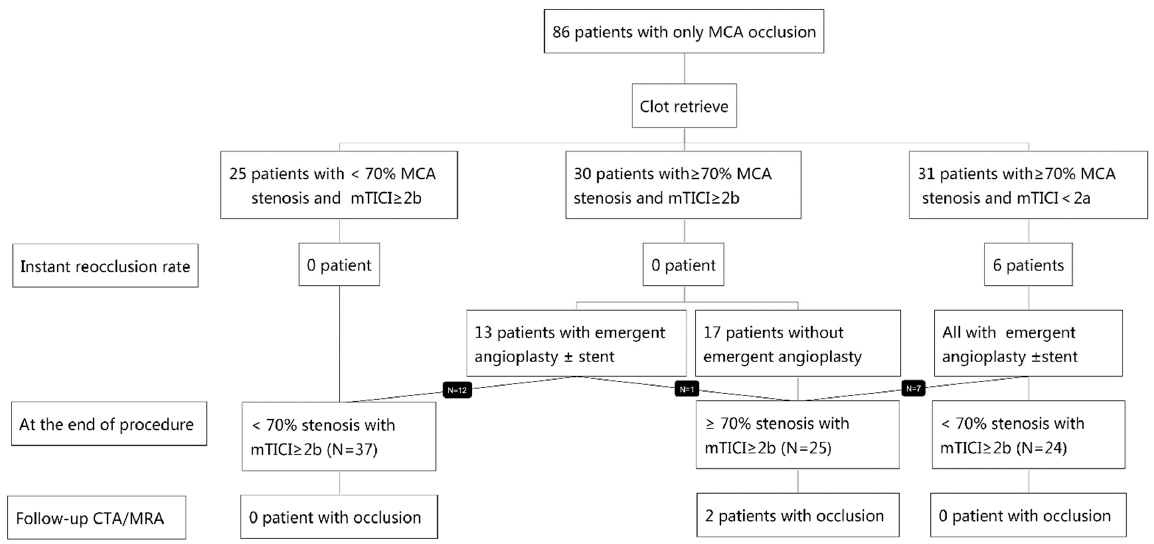
Figure 2. Decision-making flow chart. EVT, endovascular therapy; MCA, middle cerebral artery; mTICI, modified thrombolysis in cerebral infarction; CTA, computed tomography angiography; MRA, magnetic resonance angiography.